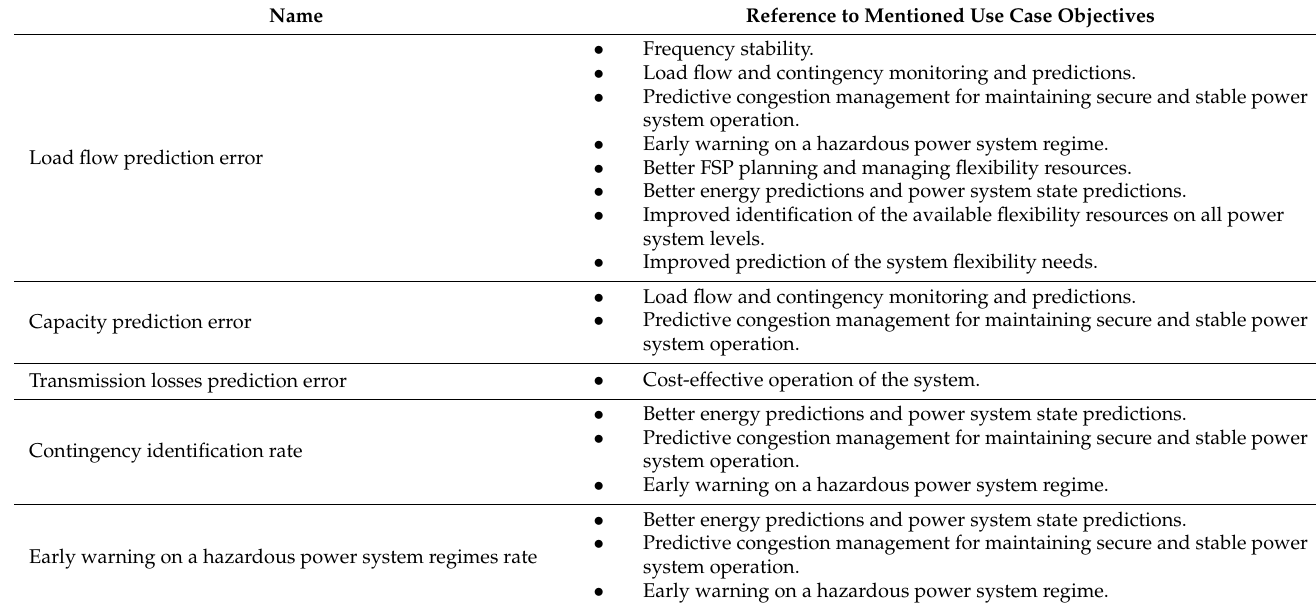
Table 9. The KPIs for the SUC